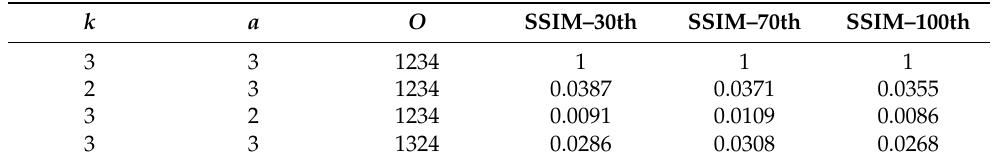
Table 2. The results by using different initial